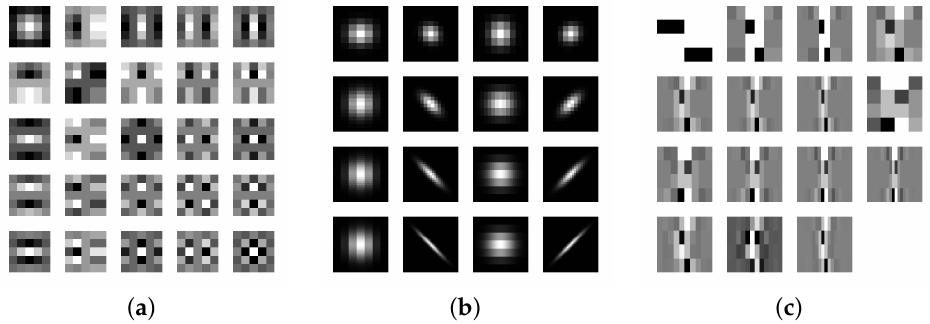
Figure 5. Samples of filter banks: Laws’ masks ( a ), Gabor filters ( b ) and bi-orthogonal wavelets ( c